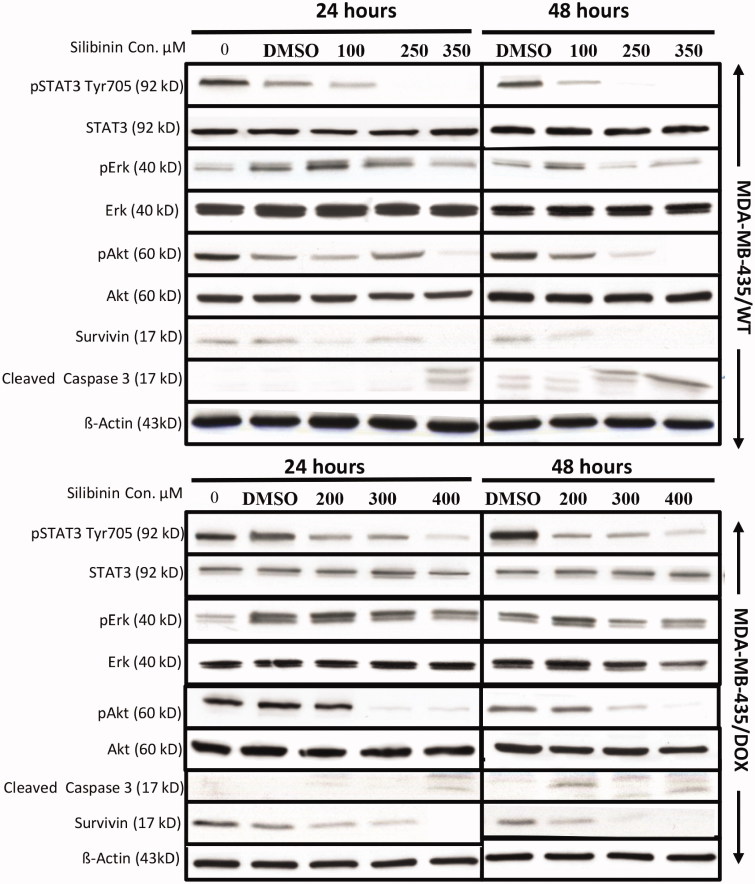
Suppressive effects of silibinin on key oncogenic pathways in MDA-MB-435/WT and MDA-MB-435/DOX cell lines. Western blotting was used to measure the level of oncogenic proteins in the cells treated with an increasing concentration of silibinin. These results are representative of three independent experiments.